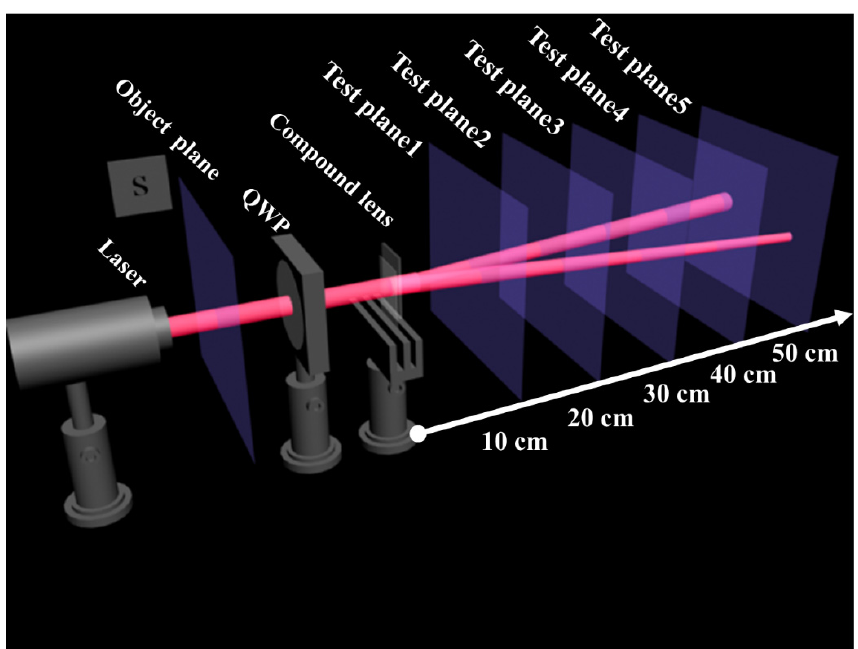
Figure 7. Illustration of experiment setups for optical performance of fabricated FLC lens.